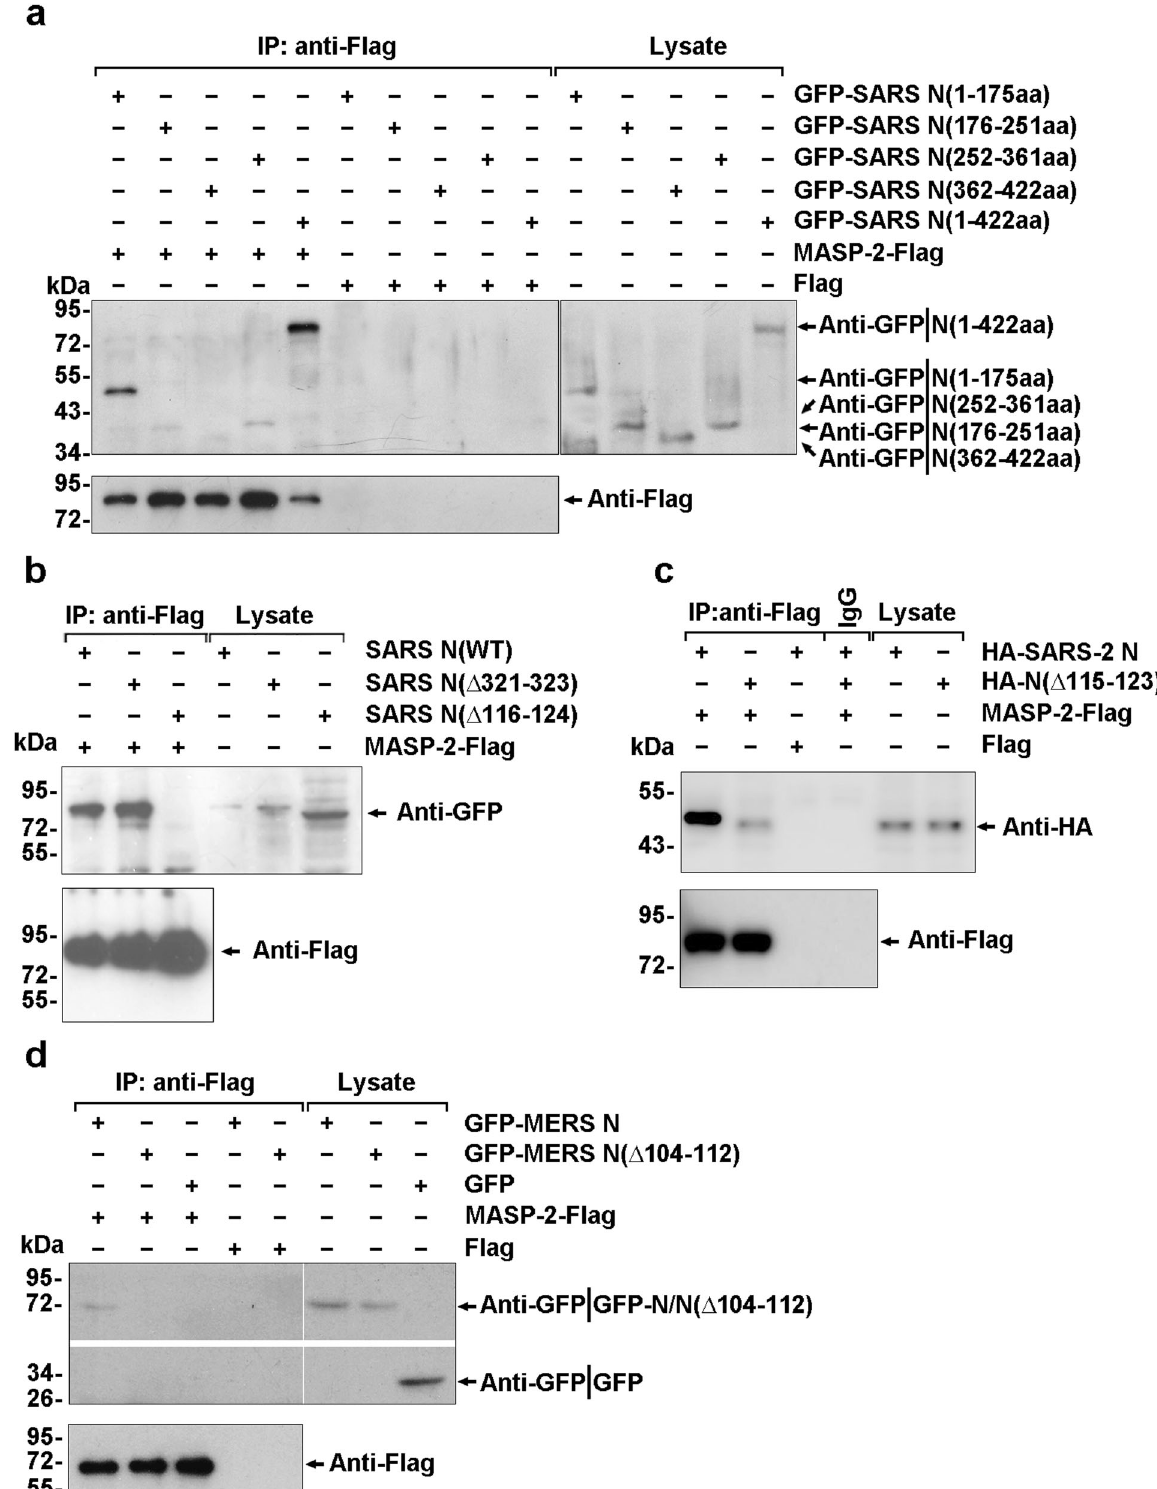
CoV-2 N protein potentiated C4b deposition could be blocked by anti-MBL, anti-MASP-2 or anti-N protein (Fig. 4f). Much less but detectable C4b deposition was observed in the wells without mannan coating (Fig. 4f). Taken together, these results suggest that the S protein or mannan and MBL are very important for